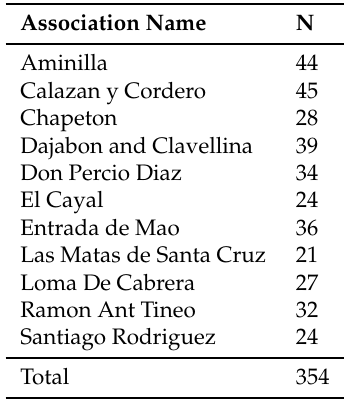
Table 1. Number of Participants by